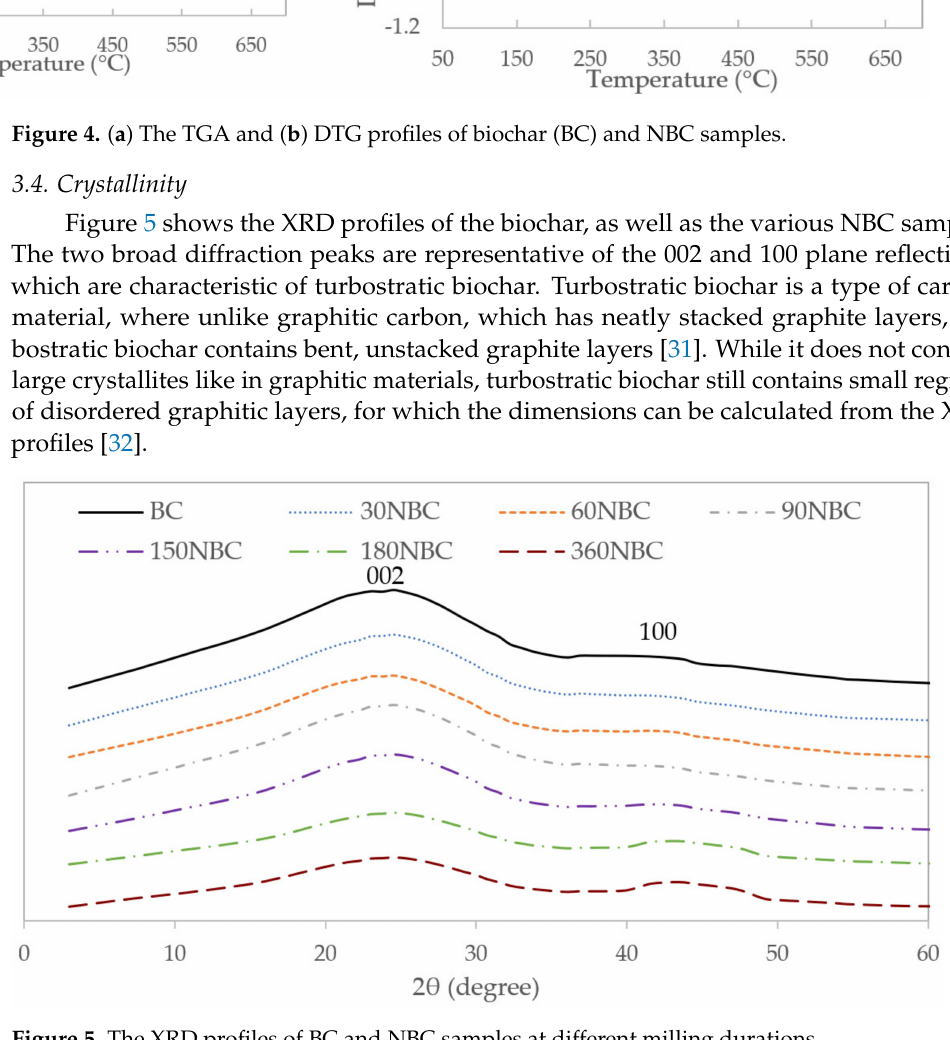
Figure 5. The XRD profiles of BC and NBC samples at different milling